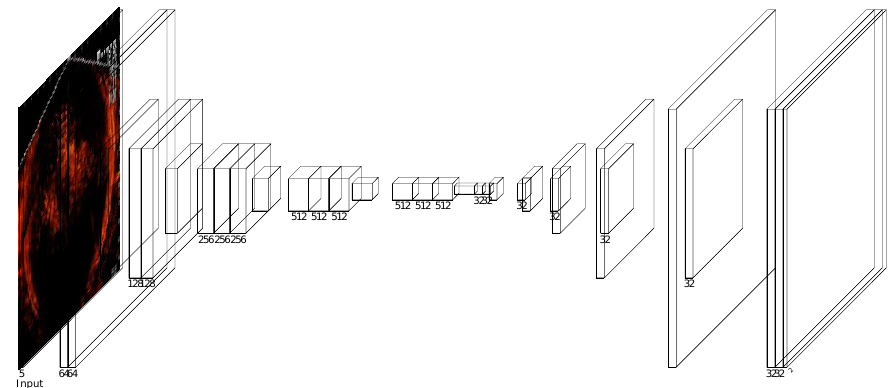
Figure 17. The neural network architecture for segmenting fish regions in the sonar image.